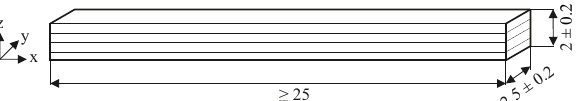
Figure 4. Flexural strength specimen type A [mm] with ilustration of layers